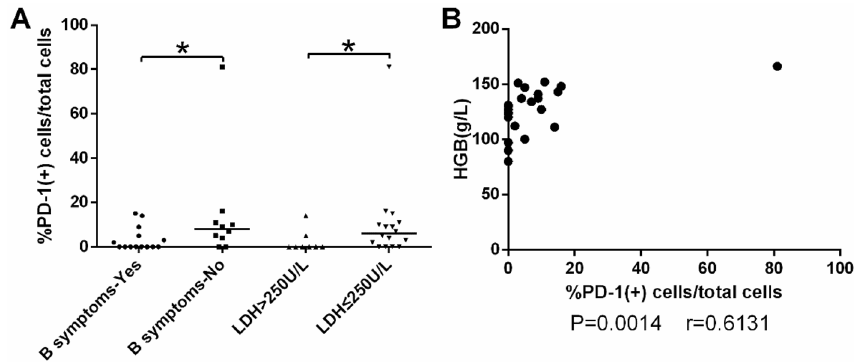
Figure 3. ( A , B ) In ENKTL patients, PD-1 level in tumor tissues varied with ( A ) B symptoms # , ( A ) lactate dehydrogenase (LDH) concentration, ( B ) hemoglobin. *P < 0.05. # The B symptoms of lymphoma mainly refer to systemic symptoms, which usually include three aspects: (1) Fever, with a body temperature above 38 °C, usually for more than 3 consecutive days, but there is no clear clinical cause of infection. (2) The weight loss reached more than 10% within 6 months. (3) Night sweats. The so-called night sweats refer to the sweating of the patient after falling